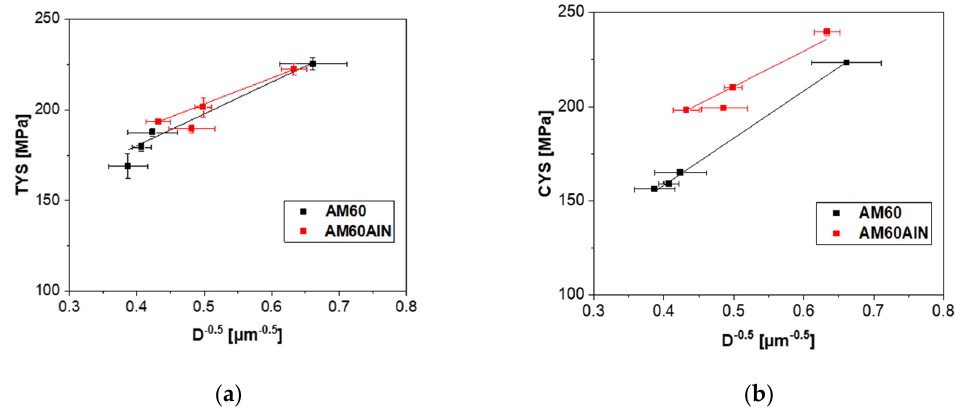
Figure 7. Hall–Petch plot of ( a ) tensile and ( b ) compressive yield strength over the reciprocal of the square root of grain size D following Equation (1). Table 2. Results of Hall–Petch relation (Equation (1)) for tension and compression tests of AM60 and AM60AlN alloys, where (cid:2026) (cid:3052) is the yield stress, (cid:2026) (cid:2868) is the friction stress that allows dislocations